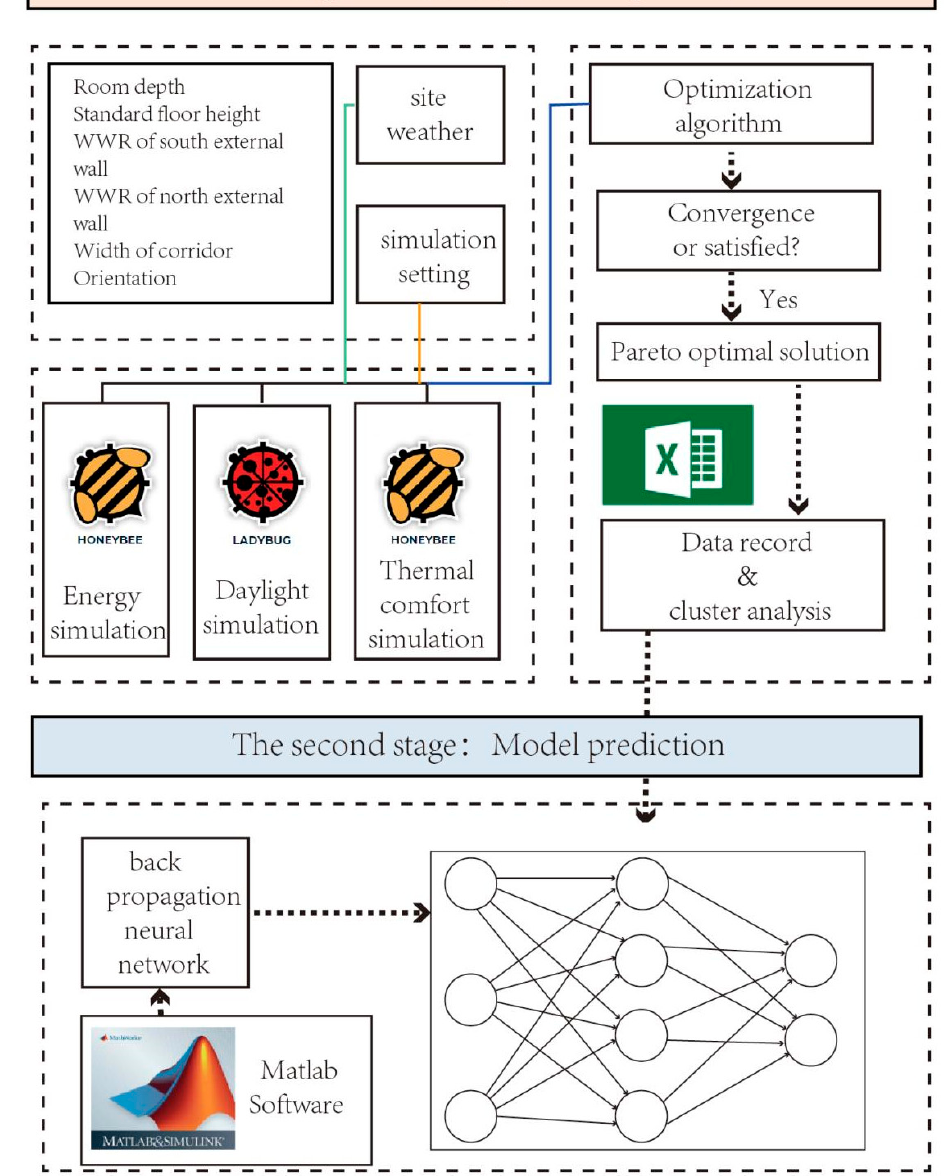
Figure 1. Two stages of the early design of middle school architecture.